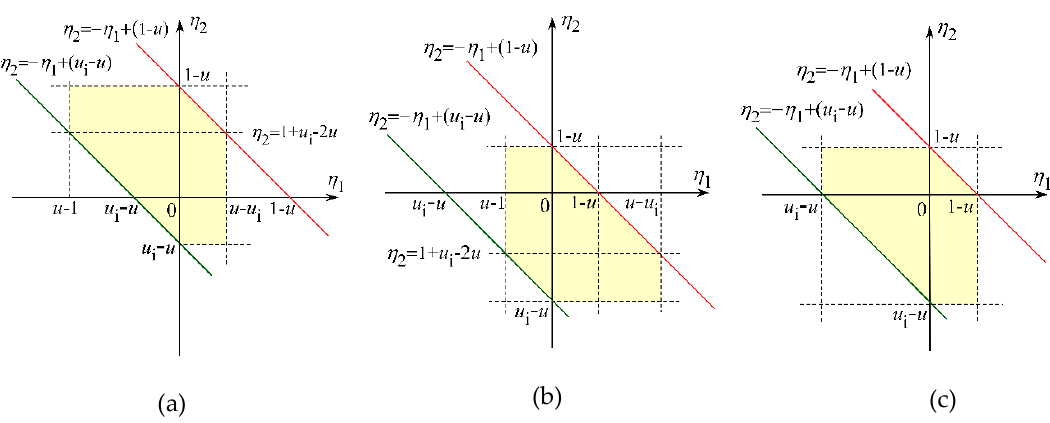
Figure A2. Domains highlighted in yellow for double integrals in ( a ) G for u i < u < ( u i + 1)/2, ( b ) G for ( u i + 1)/2 < u < 1, and ( c ) H for u i < u < 1. u = τ / τ e , u c = τ c / τ e , u i = τ i / τ e